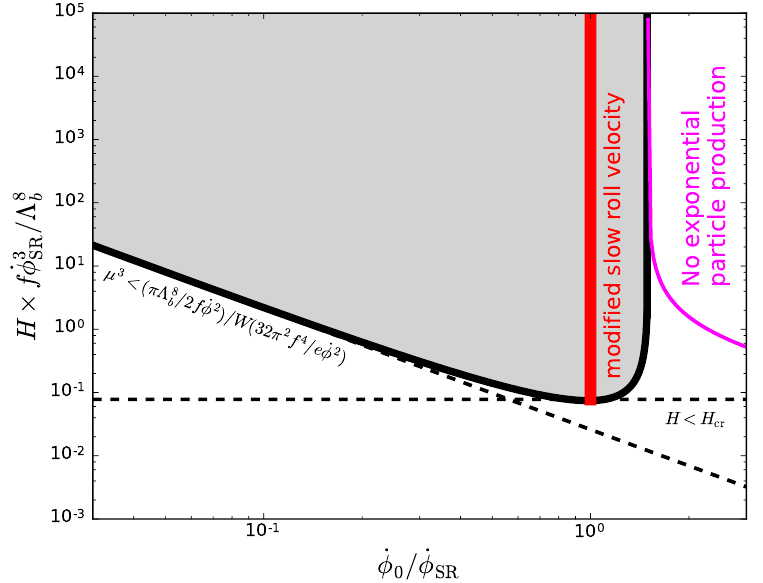
Figure 6 . The parameter space which is excluded by eq. (3.16). The ratio between the decay constant and the slow roll velocity is (cid:12)xed to f 2 = _ (cid:30) SR = 10 4 . The coe(cid:14)cient of the slope is (cid:12)xed to (cid:22) 3 = 3 H _ (cid:30) SR . Eq. (3.16) is not satis(cid:12)ed in the gray regions. The red solid line shows the modi(cid:12)ed slow roll velocity _ (cid:30) given in eq. (B.33). H cr is de(cid:12)ned in eq. (3.23). The magenta line SR(frag)